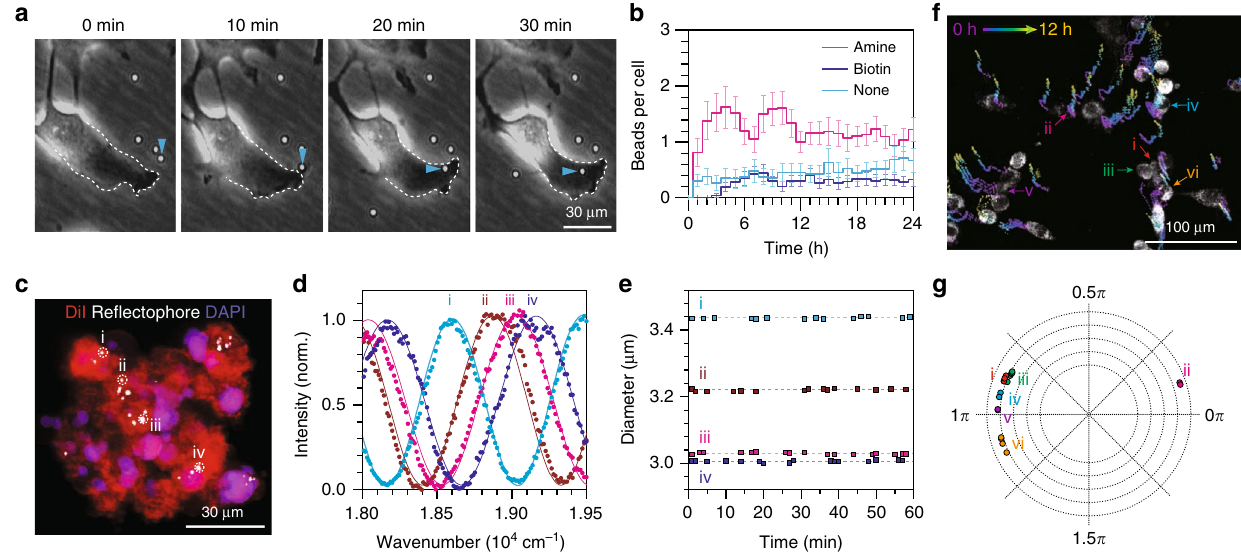
Fig. 5 Intracellular re fl ectophores. a Time-lapse phase-contrast images of live Hela cells in culture engul fi ng re fl ectophores. Arrowheads indicate the re fl ectophore under endocytosis. The dotted line demarcates the cell ’ s margin. b Population kinetics of intracellular uptake for surface-functionalized polystyrene re fl ectophores ( d ≈ 3 μ m). The number of samples for each group: n = 45 cells for “ amine ” , n = 66 cells for “ biotin ” , and n = 50 cells for “ none ” . The error bar represents standard error of the mean. c A long-term 3D spheroid culture. Hela cells loaded with re fl ectophores were subsequently cultured over several days to form a tumor spheroid. d Representative spectral measurements on intracellular re fl ectophores annotated in c . The measured diameters are 3436 nm for “ i ” , 3212 nm for “ ii ” , 3029 nm for ‘ iii ’ , and 3006 nm for “ iv ” . The solid sinusoidal curves are the best- fi t simulation spectra ( R 2 : 0.99 for “ i ” , 0.98 for “ ii ” , 0.99 for “ iii ” , and 0.97 for “ iv ” ). e Measurement precision for intracellular re fl ectophores. Individual intracellular re fl ectophores annotated in c were traced over 60 min. The measured diameters are 3436 ± 2.6 nm for ‘ i ’ , 3212 ± 3.1 nm for ‘ ii ’ , 3029 ± 2.9 nm for ‘ iii ’ , and 3006 ± 2.6 nm for “ iv ” in mean ± standard deviation. The dotted lines indicate the means. f Barcoded cell tracking over 12 h with intracellular re fl ectophores. Grayscale image indicates MitoTracker fl uorescence and pseudo-colored traces represent time-series tracking of individual re fl ectophores over time. g Phasor representation of six representative re fl ectophores measured at multiple time points. The measured diameters are 3169 ± 0.2 nm for “ i ” , 3379 ± 1.8 nm for “ ii ” , 3015 ± 0.2 nm for “ iii ” , 3165 ± 0.7 nm for “ iv ” , 3155 ± 2.1 for “ v ” , and 3147 ± 0.9 nm for “ vi ” in mean ± standard